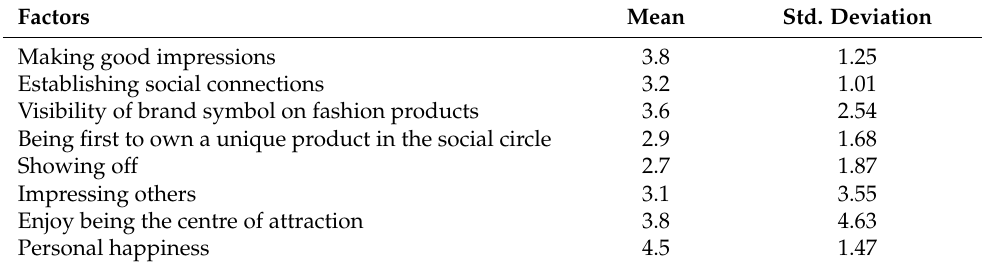
Table A1. Motivational factors influence on purchasing luxury brands.